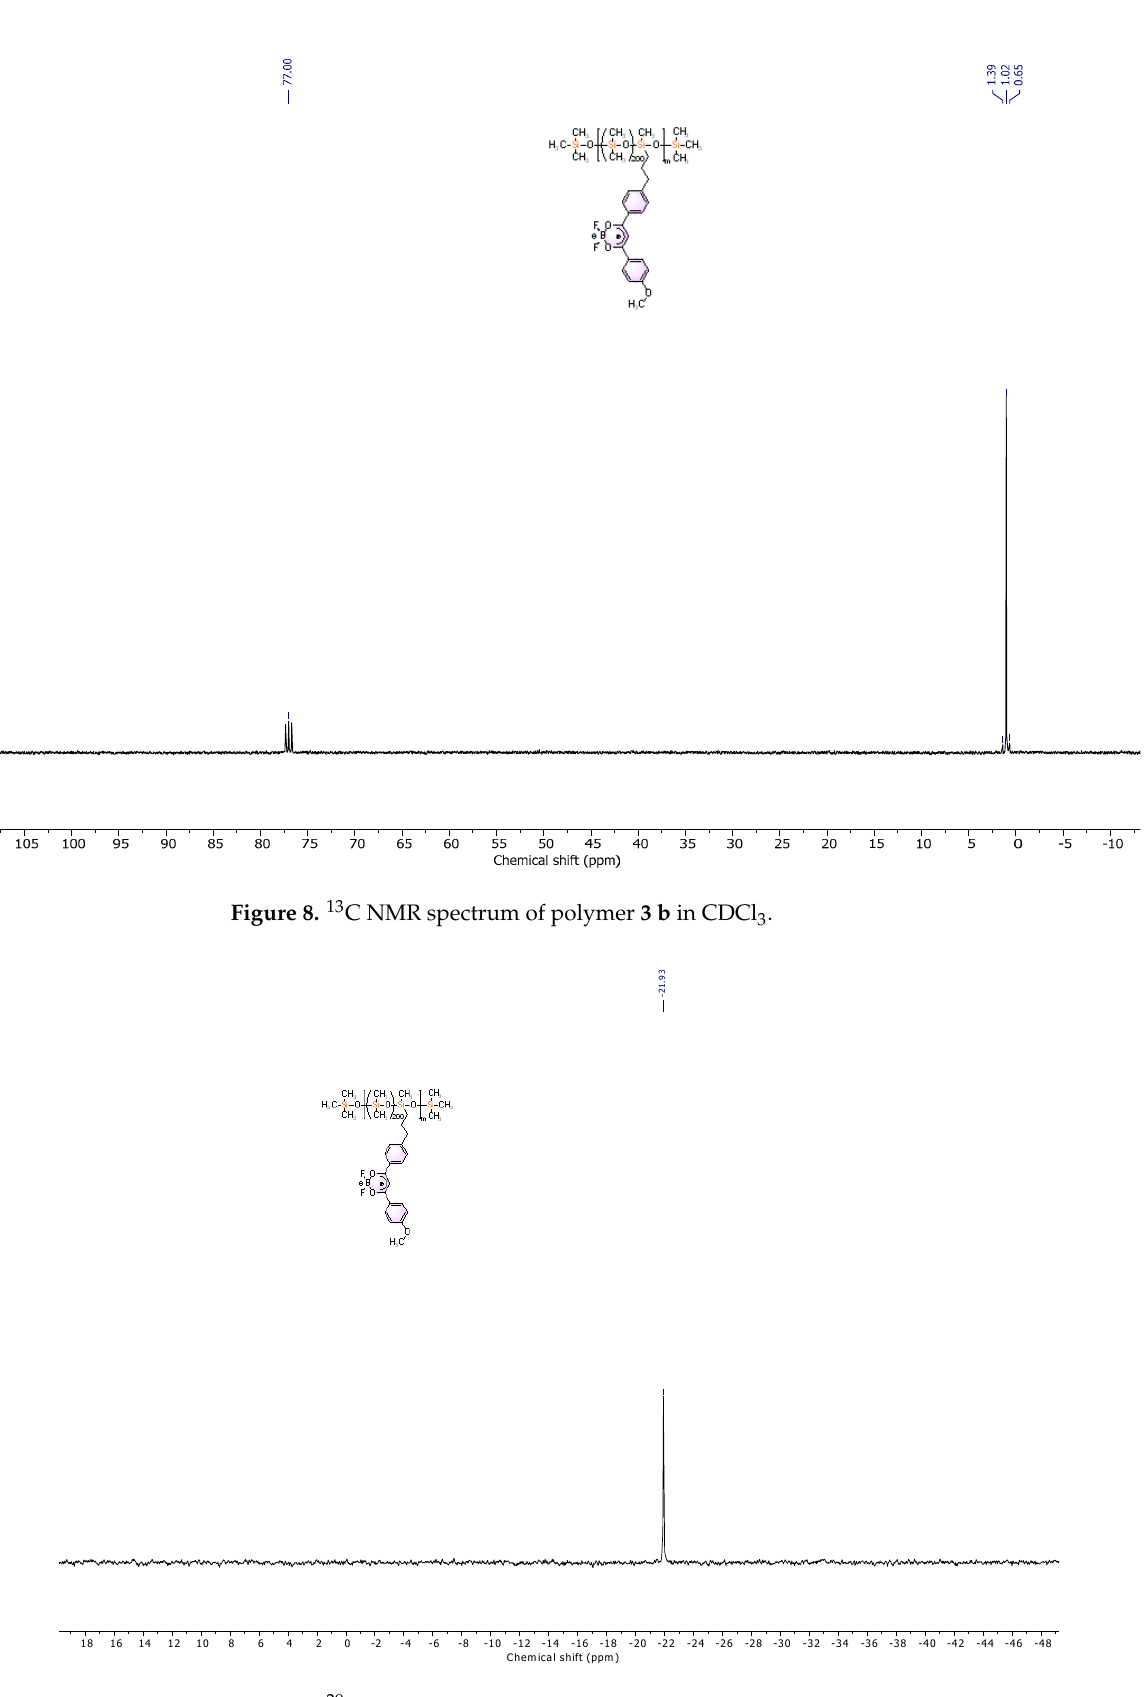
Figure 7. 1 H NMR spectrum of polymer 3 b in CDCl 3 .